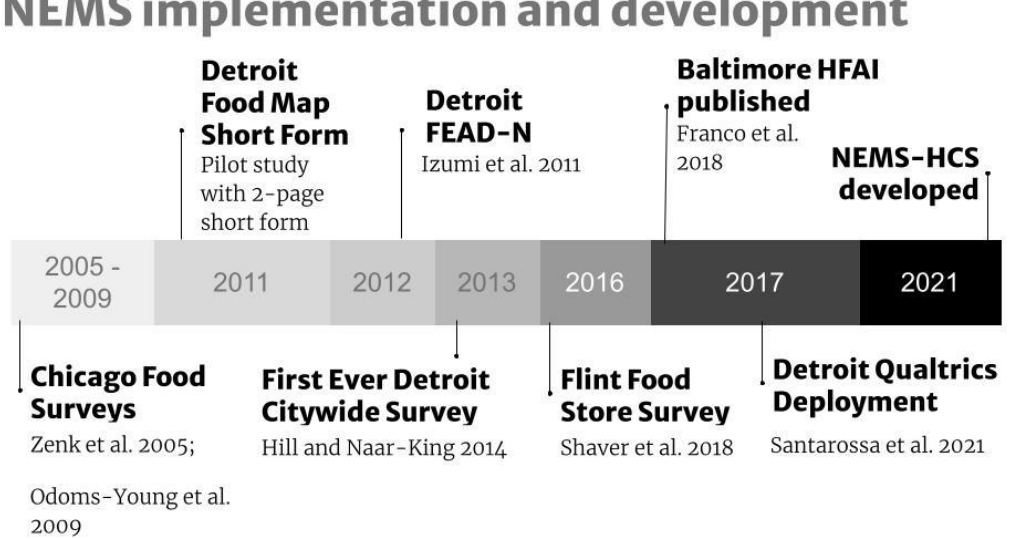
Figure 1. Timeline of food environment assessment instruments and their development.